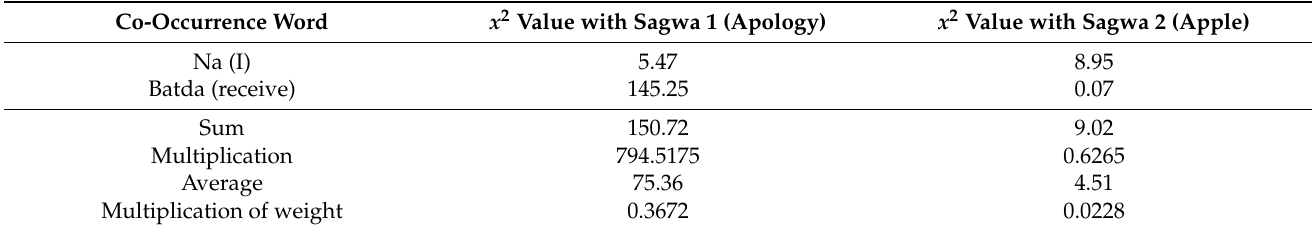
Table 4. Semantic determination method using the chi-square